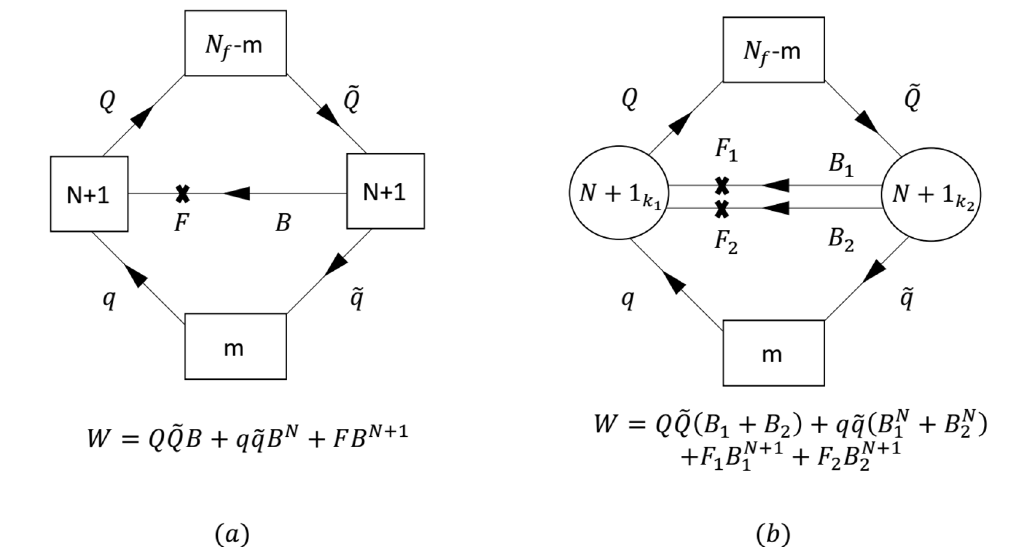
Figure 7 . The 3 d theories we conjectured are associated with the compactification of the 5 d SCFTs we consider on (a) a tube with two SU( N + 1) maximal punctures and (b) a torus.